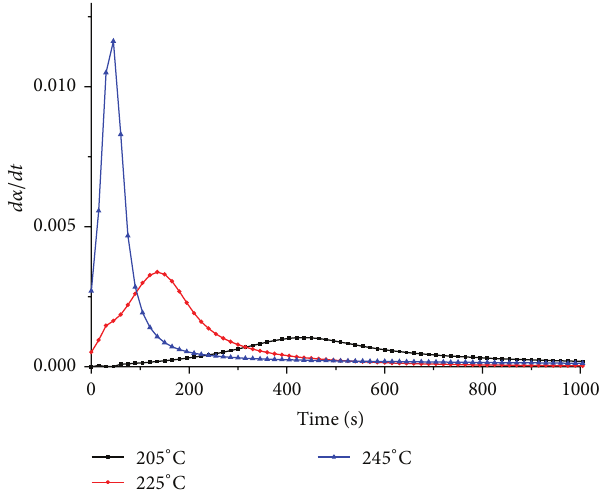
Figure 4: 𝑑𝛼/𝑑𝑡 versus time of BZ homopolymer in isothermal DSC.